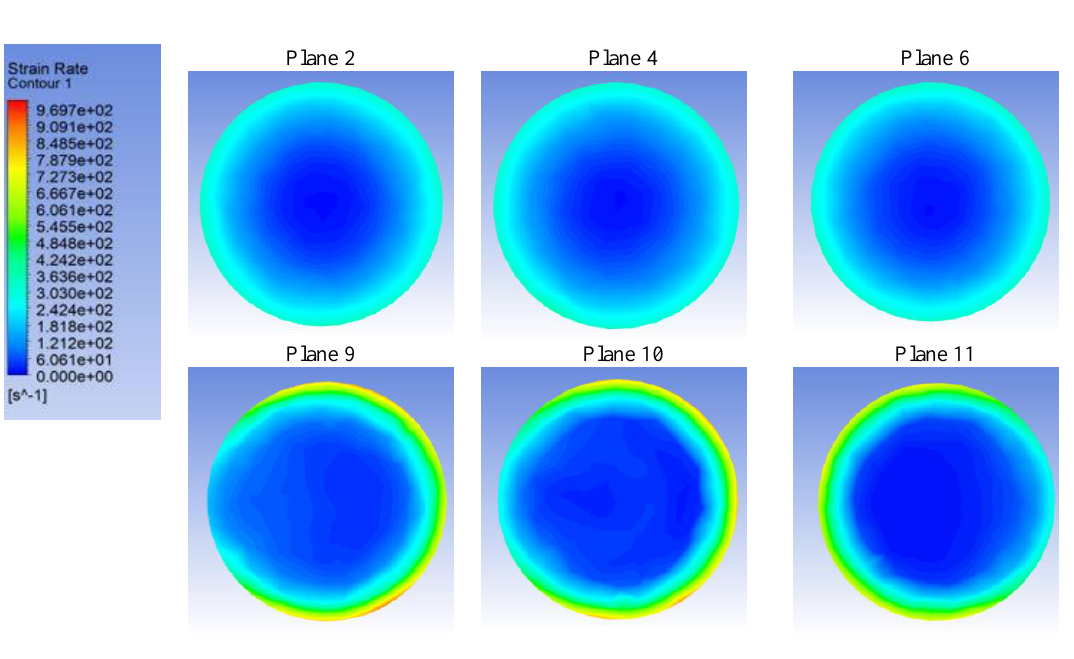
Figure 17. Strain rate at each plane location using fruit juice.